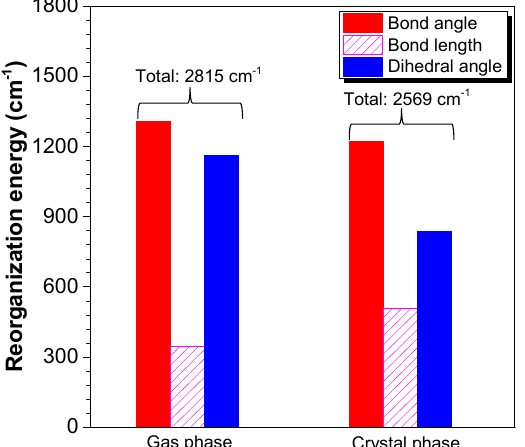
Figure 6. Contribution to the total reorganization energy in the gas and the crystal phase from the bond length, the bond angle, and the dihedral angle. Table 2. The calculated electric transition dipole moments ( µ ), radiative rate constants ( k r ) and nonradiative rate constants ( k ic ) of TPPM-4M in the gas phase and the crystal phase ( T = 300 K).